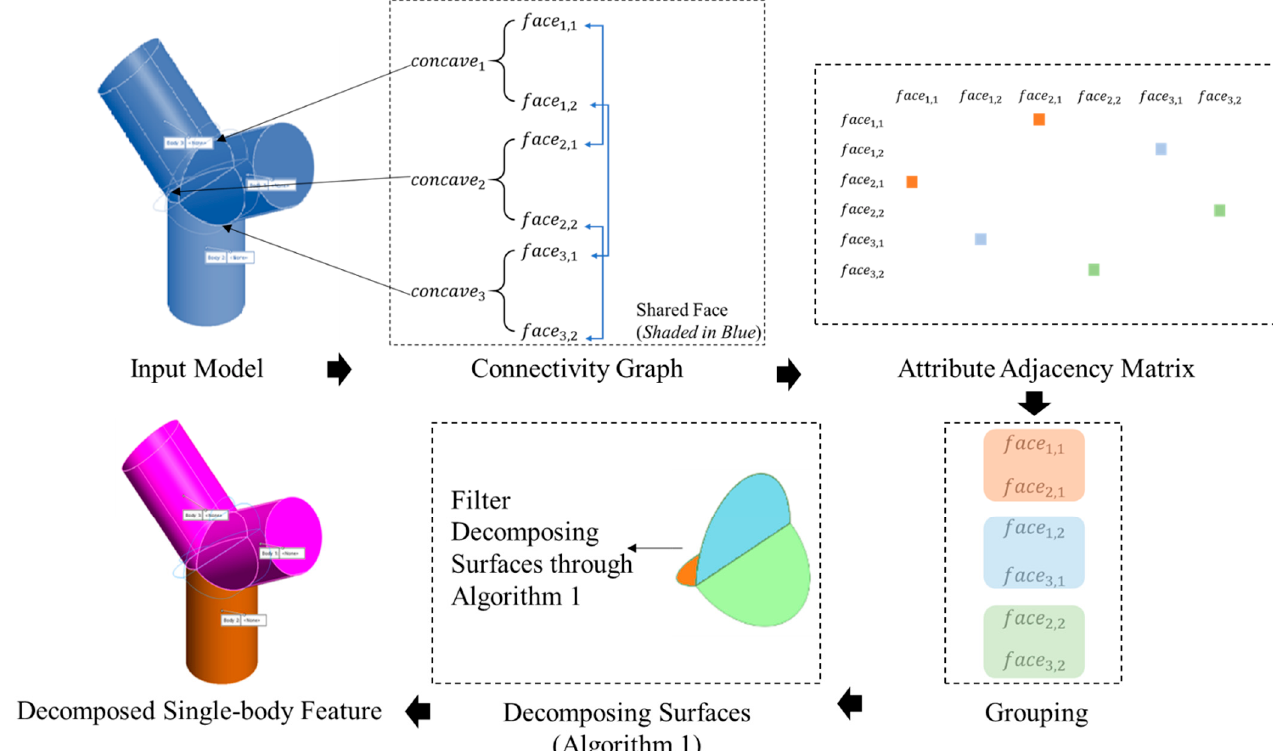
Figure 5. Overall workflow of a robotic AM single-body feature decomposition.